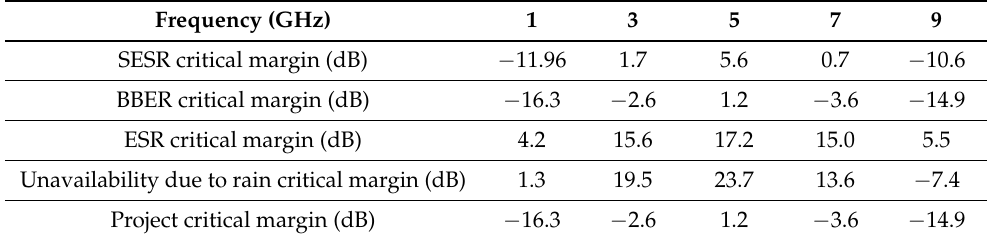
Table 6. The critical margins of project clauses for the simulated terrestrial